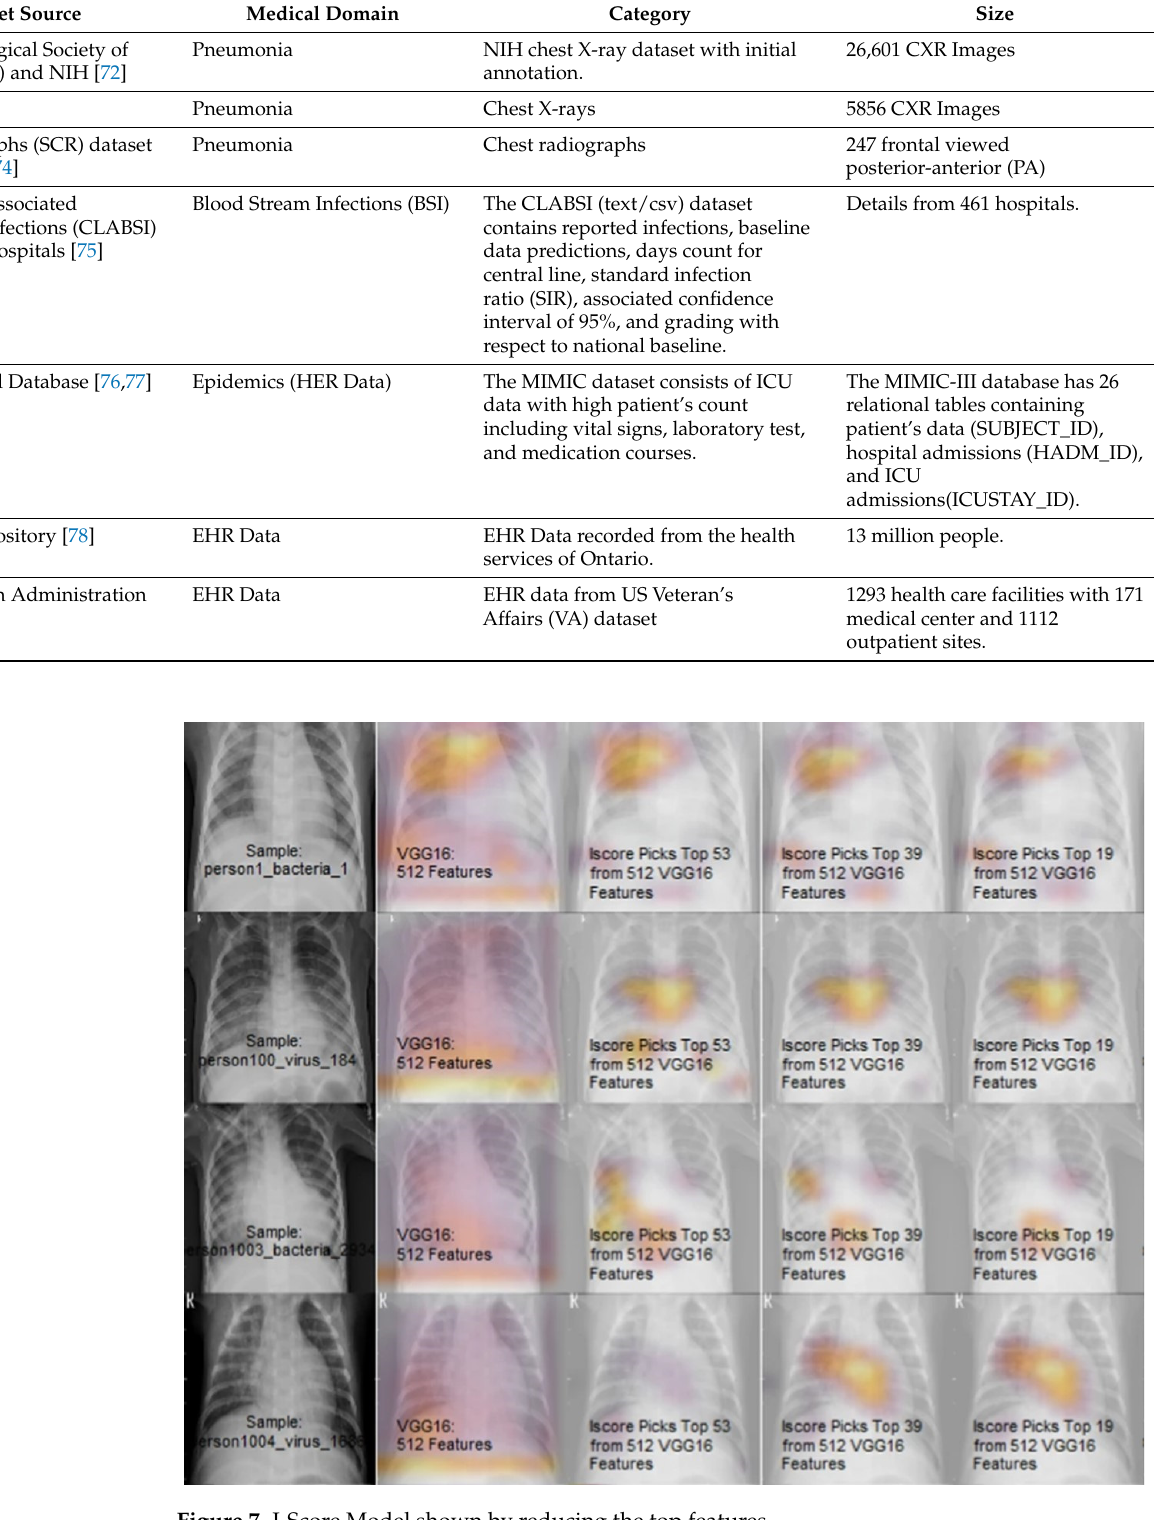
Figure 7. I-Score Model shown by reducing the top